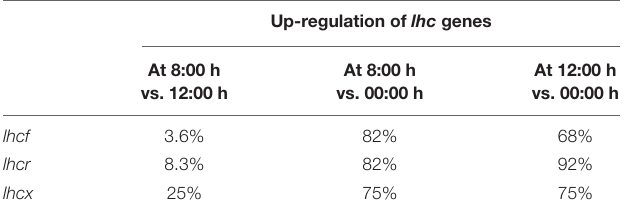
TABLE 4 | Percentages of lhcf , lhcr , or lhcx genes upregulated at 8:00 and 12:00 h in the dynamic light (DL) experiment. Up-regulation of lhc